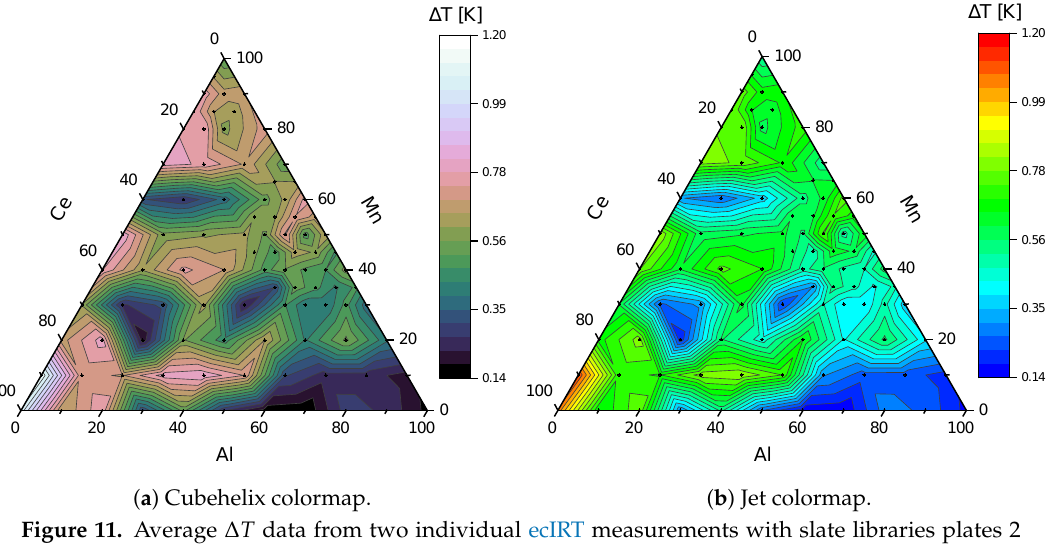
Figure 11. Average ∆ T data from two individual ecIRT measurements with slate libraries plates 2 and 3. Sample composition: Pt 1.5 Rh 1.5 Al a Mn b Ce c . Axis labels denoting the mole fraction χ of given element as percentage. Sample compositions are displayed by a dot, values between dots are generated using linear